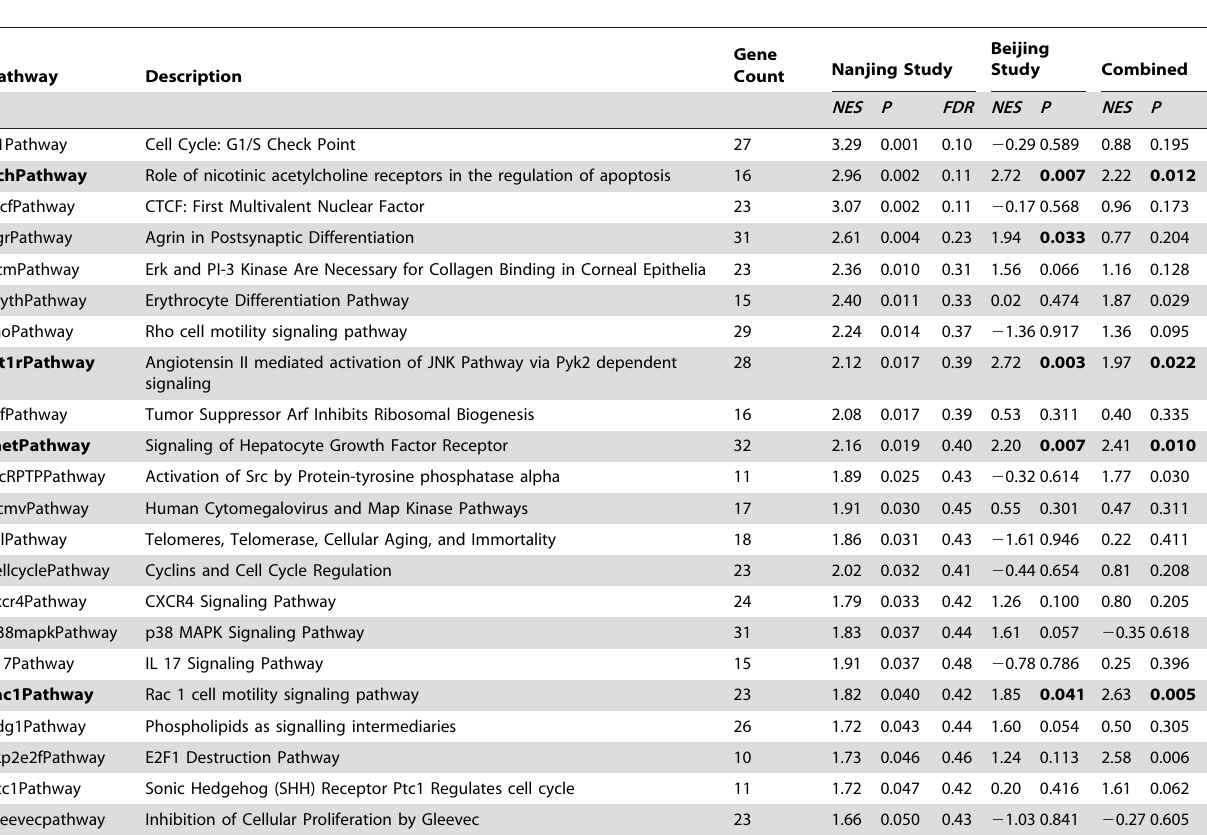
Table 1. Summary of significant pathways in Nanjing study ( P # 0.05 and FDR # 0.5) and replication in Beijing study.